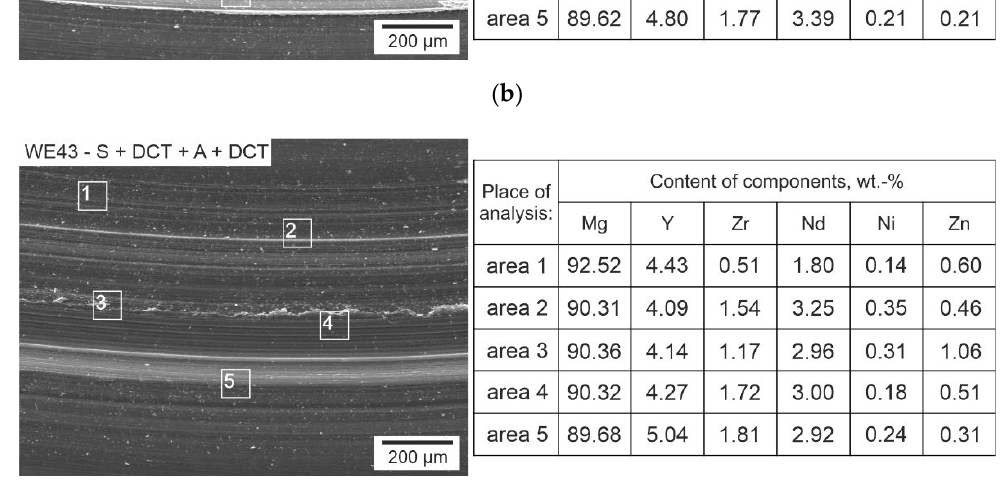
Figure 11. Microanalysis of the chemical composition of wear traces of the as-delivered WE43 alloy—( a ) ; after deep cryogenic treatment—( b ) and after sub -zero treatment combined with precipitation hardening—( c ).